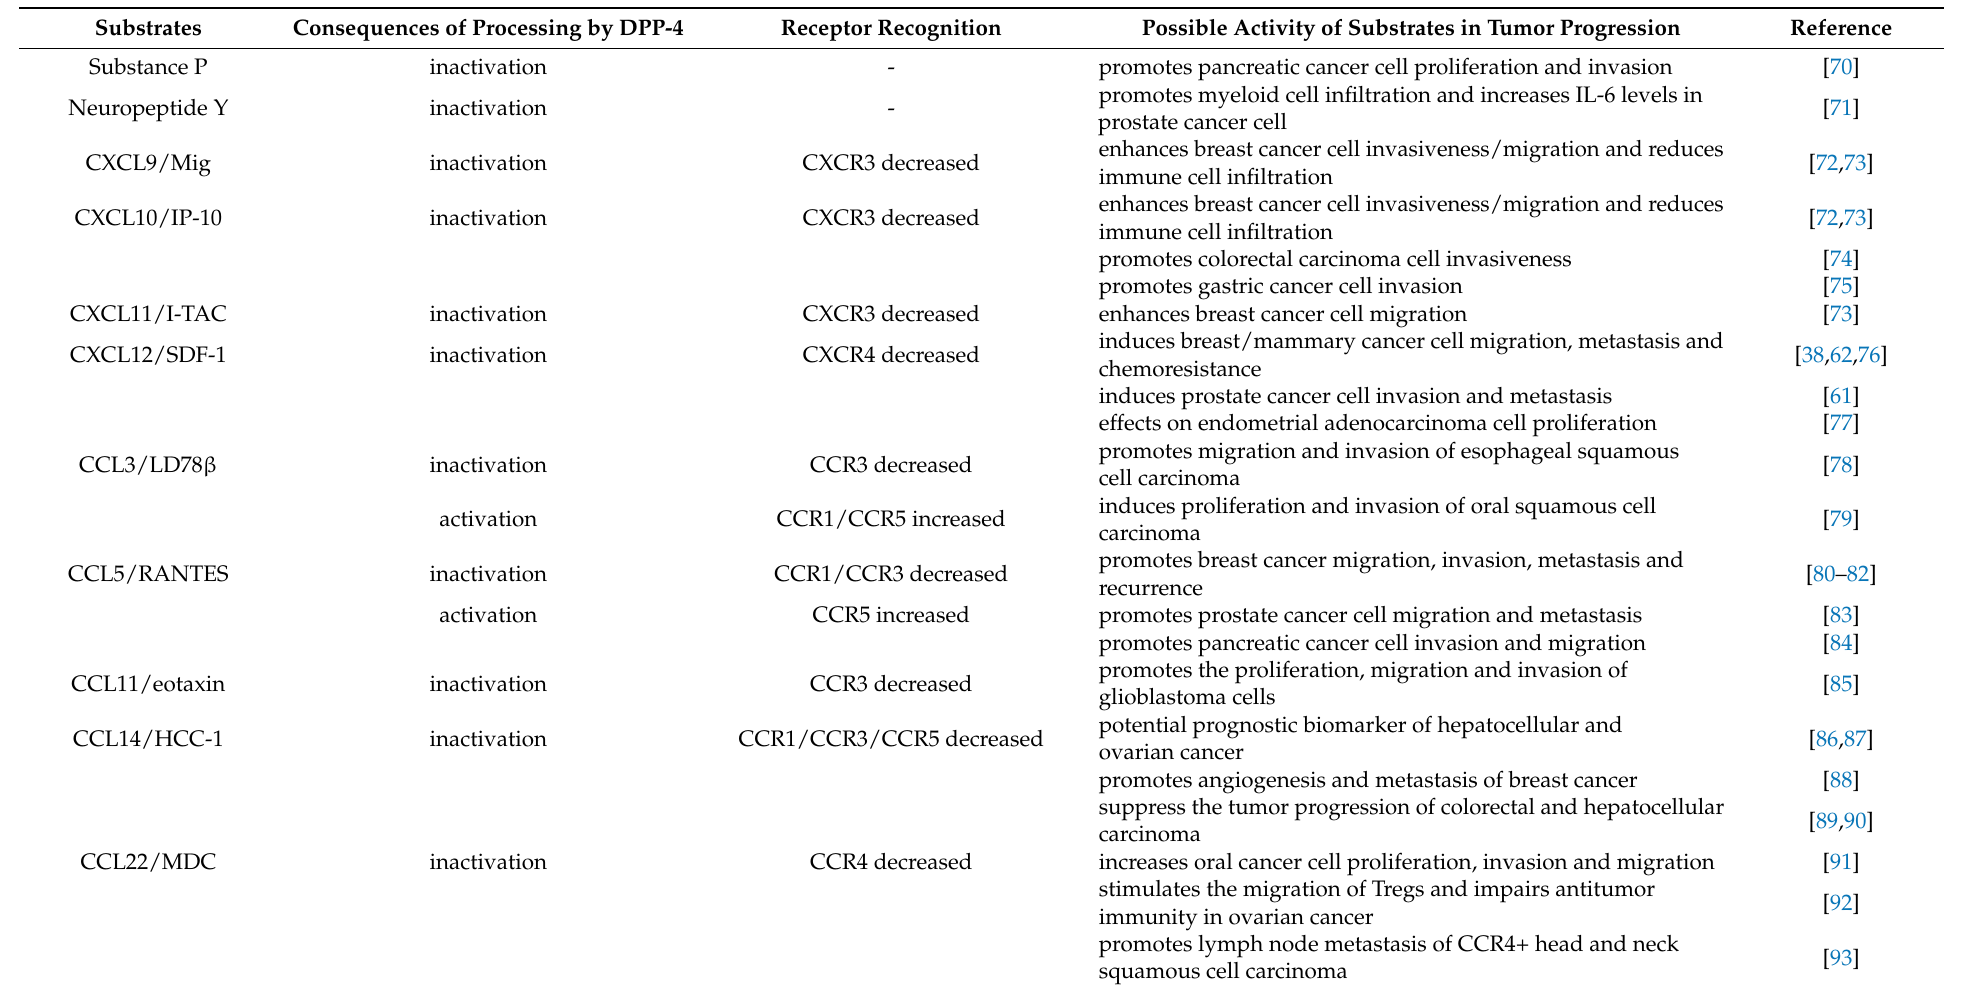
Table 2. Substrates of DPP-4/CD26 and potential downstream effect on tumor